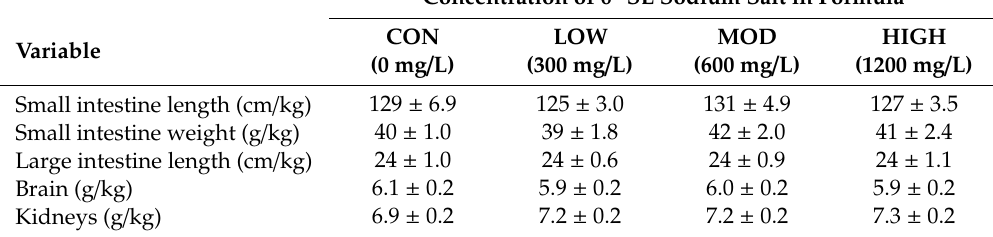
Table 1. Organ weights, small intestinal length and weight, and large intestinal length presented as value normalized by body weight of piglets fed formula containing various concentrations of 6 (cid:48) -SL sodium